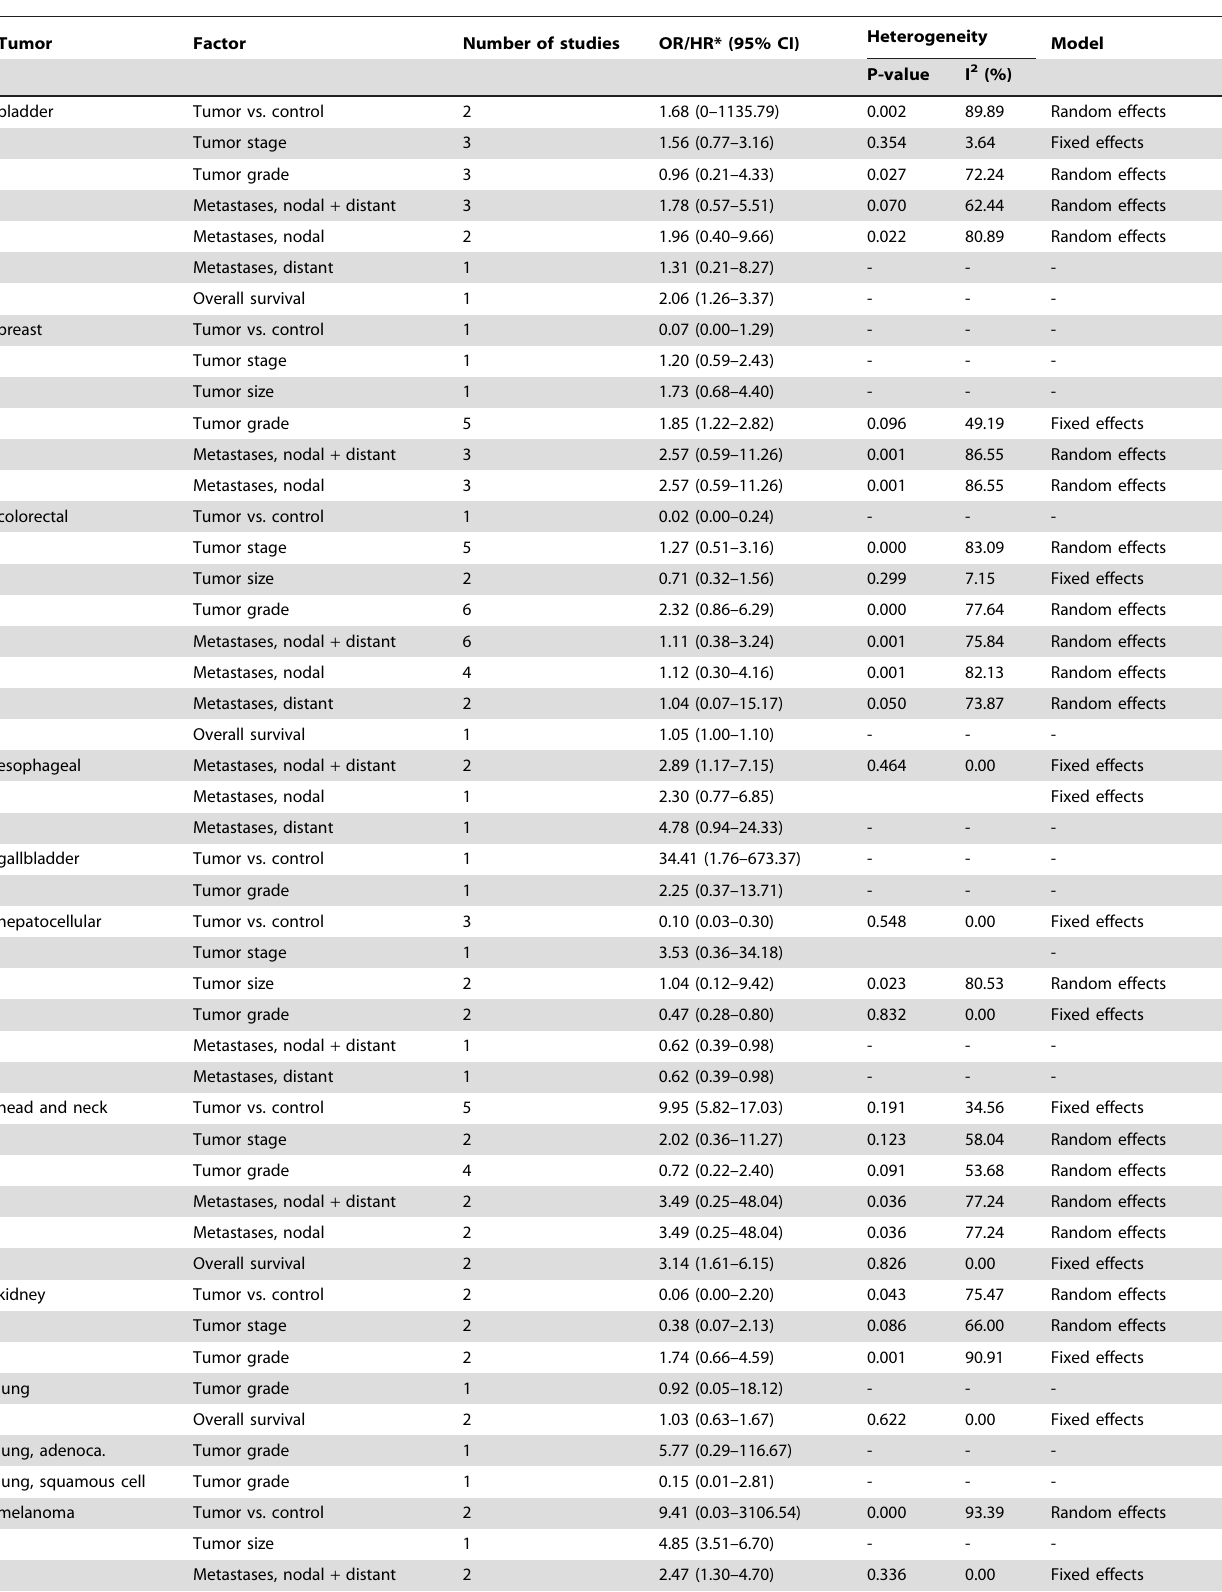
Table 2. Association of MT staining and clinicopathological factors – individual tumor types taken into account.